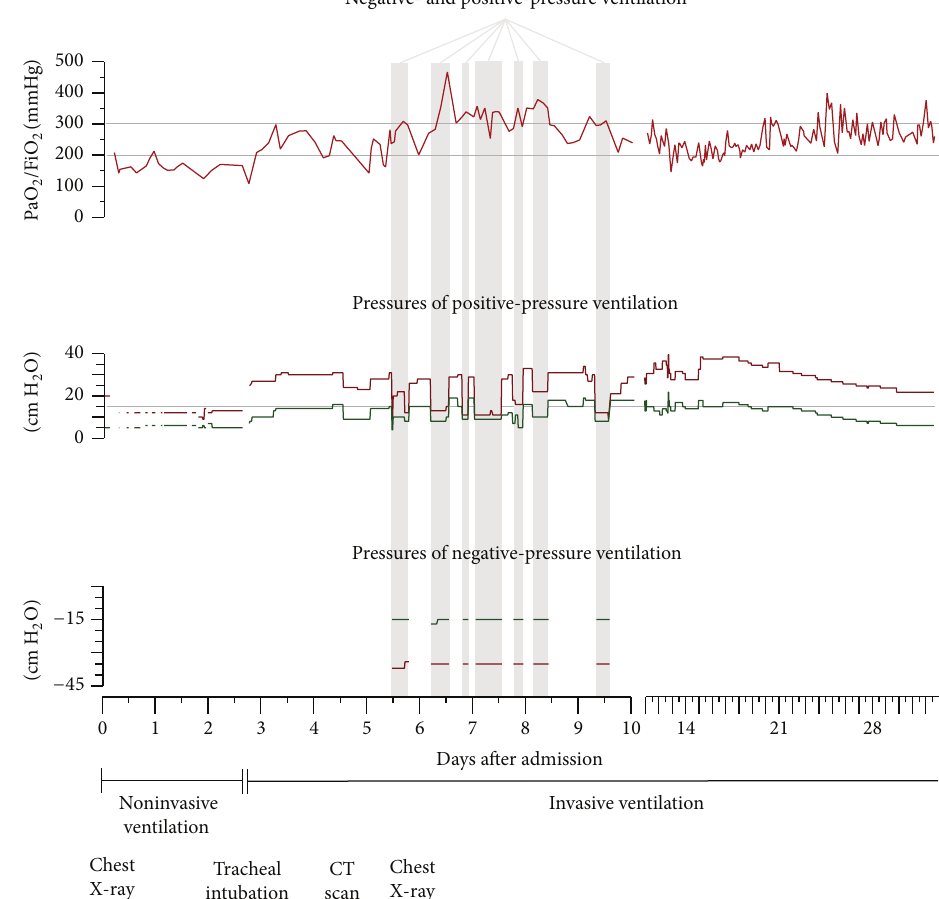
Figure 2: Course of gas exchange and ventilatory pressures. After three days of noninvasive positive-pressure ventilation, the patient was intubated and ventilated in a pressure-controlled mode. Three days later, negative-pressure ventilation was commenced in combination with conventional pressure support (gray columns). In both ventilatory modes, inspiratory pressures are shown as red and expiratory pressures as green lines. Ventilatory pressures represent inspiratory plateau pressures and positive end-expiratory pressures (PEEP) during conventional positive-pressure ventilation and maximum or minimum chamber pressures during negative-pressure